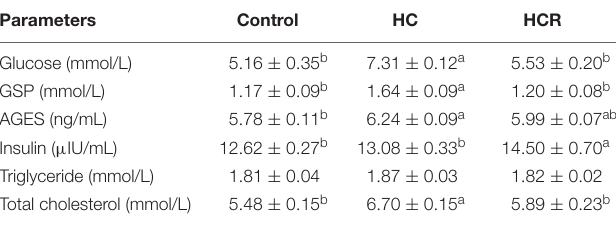
TABLE 5 | Plasma metabolites of blunt snout bream fed the different experimental diets.